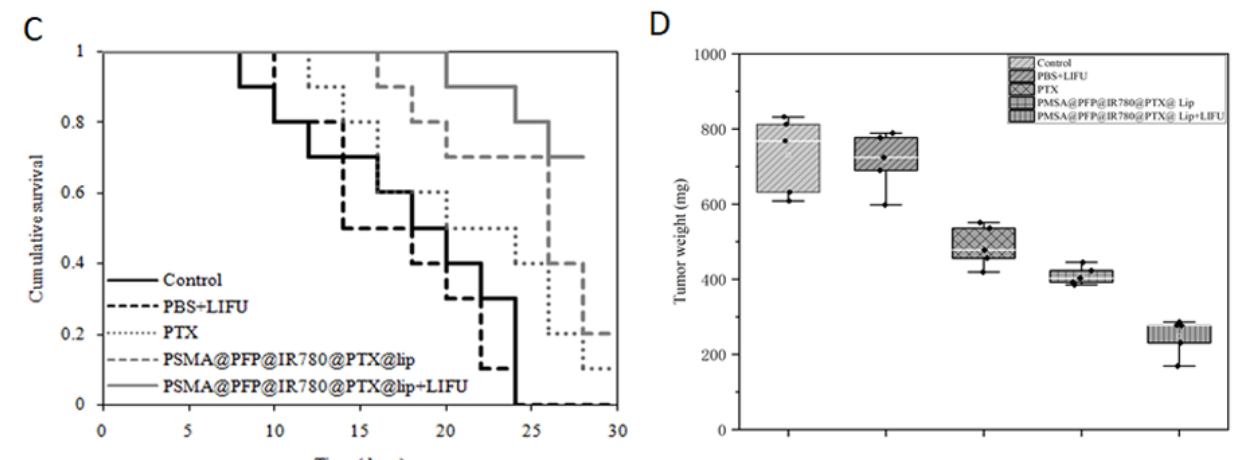
Figure 6. Antitumor efficacy of NPs in vivo: ( A ) body weight, ( B ) tumor volume, ( C ) cumulative survival of animals, and ( D ) tumor weight of nude mice subjected to different treatments. Error bars represent the means ± SD for n = 3.